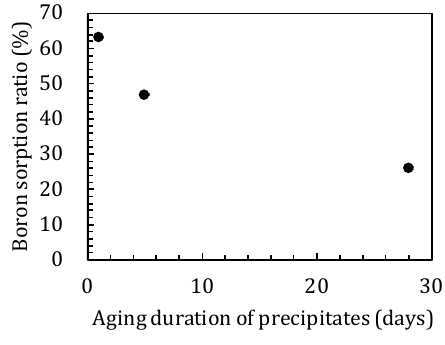
Figure 8. Differences in boron sorption ratios with aging of precipitates.